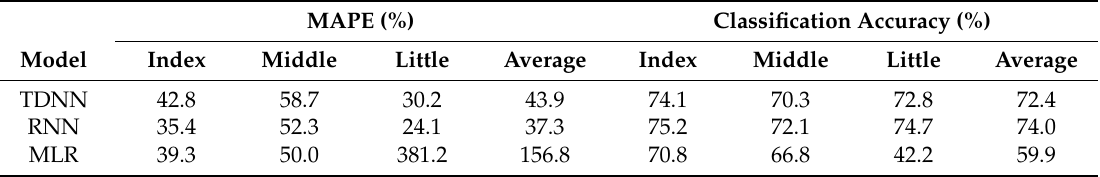
Table 3. 30-step-ahead prediction performance of seven-fold cross-validation for the three models that were